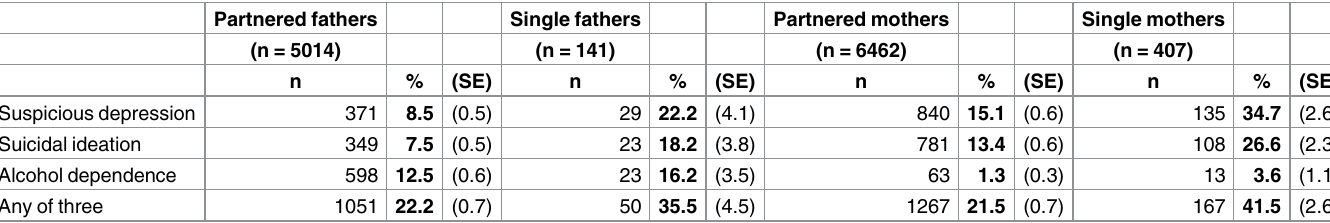
Table 2. Prevalence of poor mental status among partnered and single